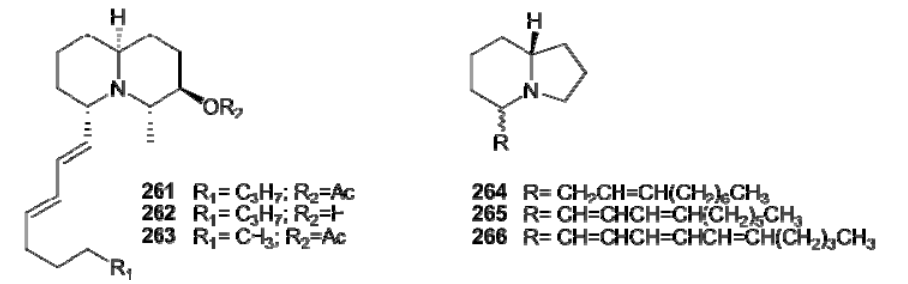
Figure 28. Structures of quinolizidine ( 261–263 ) and indolizidine ( 264–266 )